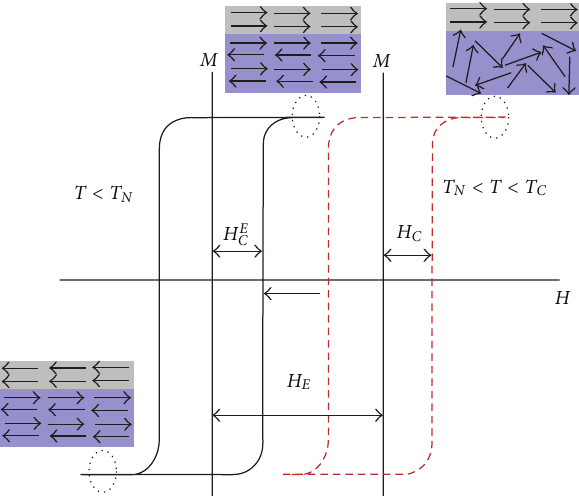
Figure 2: Schematic diagram of FM/AFM bilayer showing exchange bias e ff ect. The grey layer has AFM spin structure, while the violet one represents FM layer. M-H hysteresis loop is shifted along the field axis demonstrating exchange bias at temperature T < T N